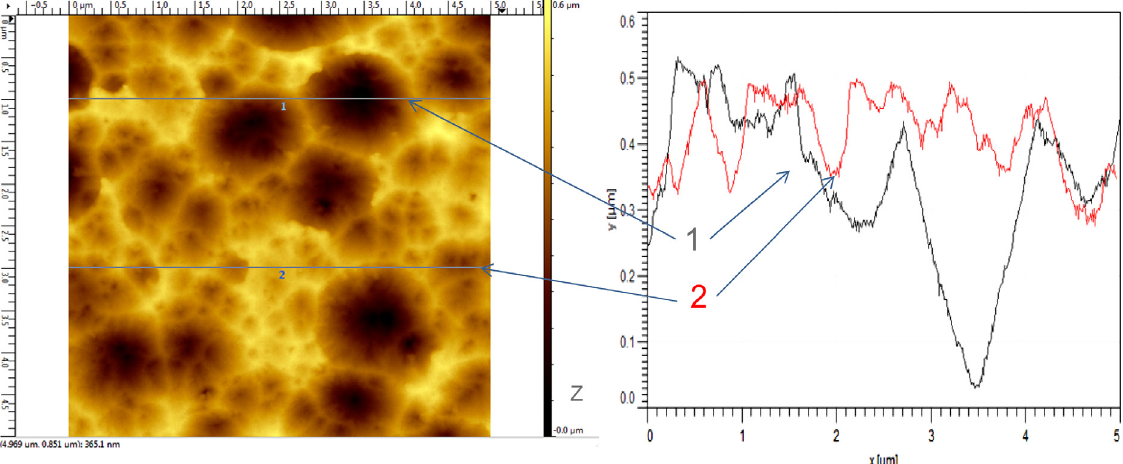
Fig. 2. AFM images of the surface of the ZnO:Al layer after etching 20 s in a 0.5 HCl chemical solution.